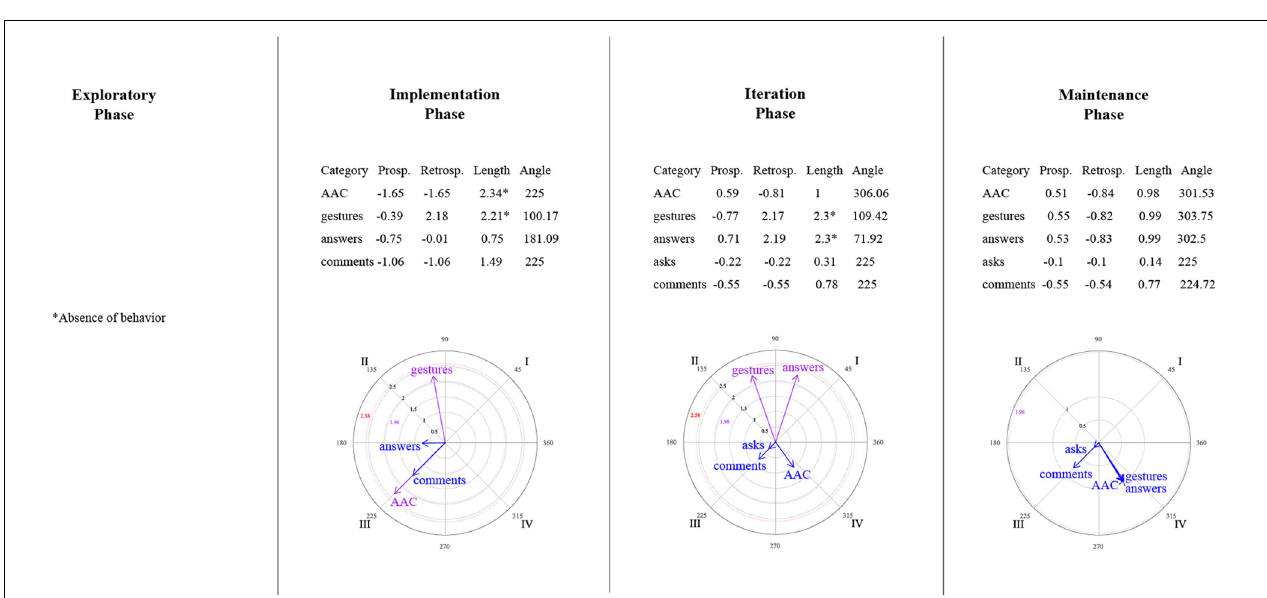
FIGURE 12 | Vectors corresponding to the mother’s providing multimodal feedback as focal behavior, and the child’s emotion-related communicative turns [answers, comments, asks] and methods of expression [AAC, conventional gestures] as conditional behaviors.